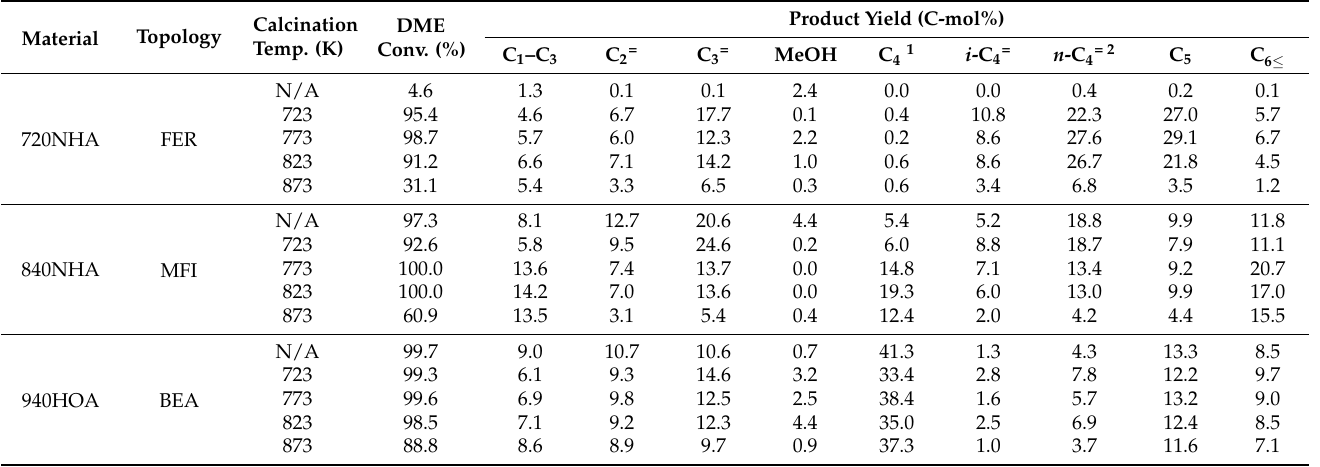
Table 2. Catalytic performance in DTO reaction using zeolites at different calcination temperatures. Calcination Material Topology Temp.